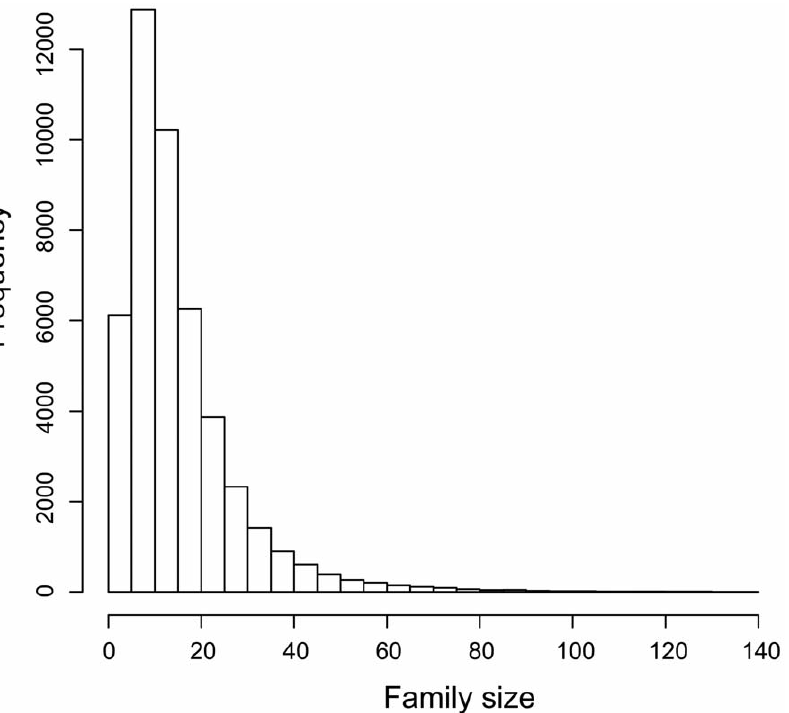
Figure 1. Distribution of gene family size with a maximum of five pairwise mismatches. Histogram of the extrapolated sizes of gene families and the frequency of each class of family size.